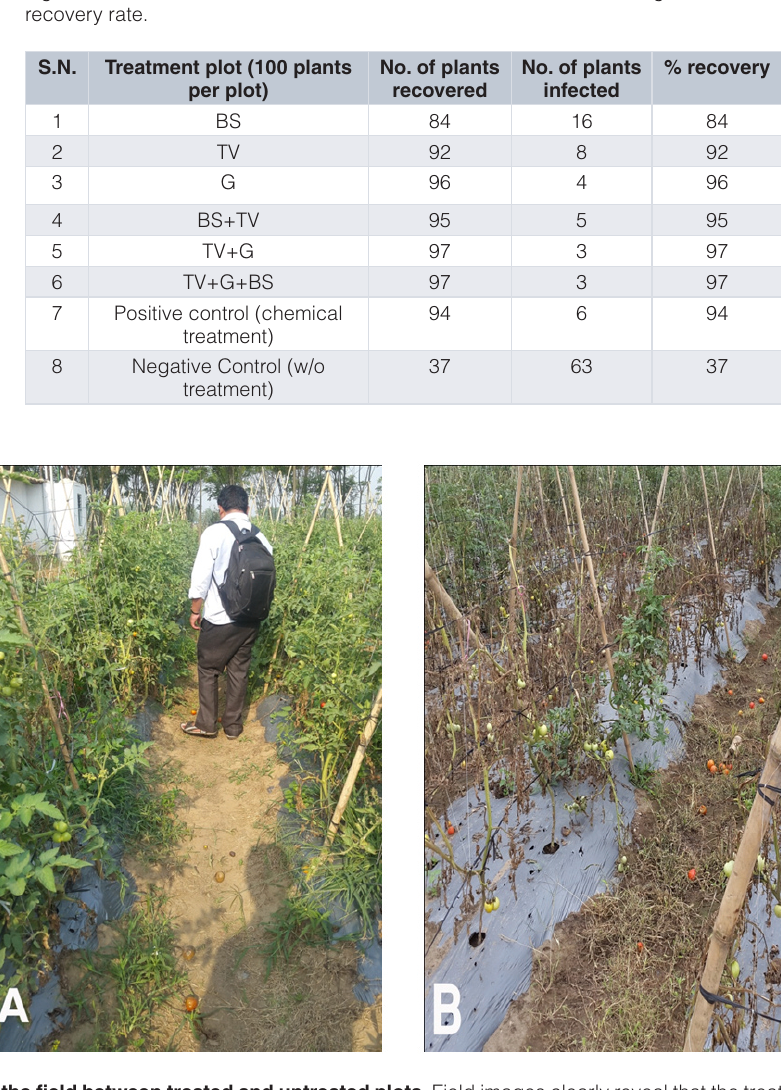
Table 5. Effect of applying biocontrol agents to tomato plants infected with bacterial wilt. There was a significant recovery of plants using a mixture of Trichoderma species and Pseudomonas fluorescens , and the recovery rate was higher than that of chemical treatment. Bacillus subtilis did not show significant